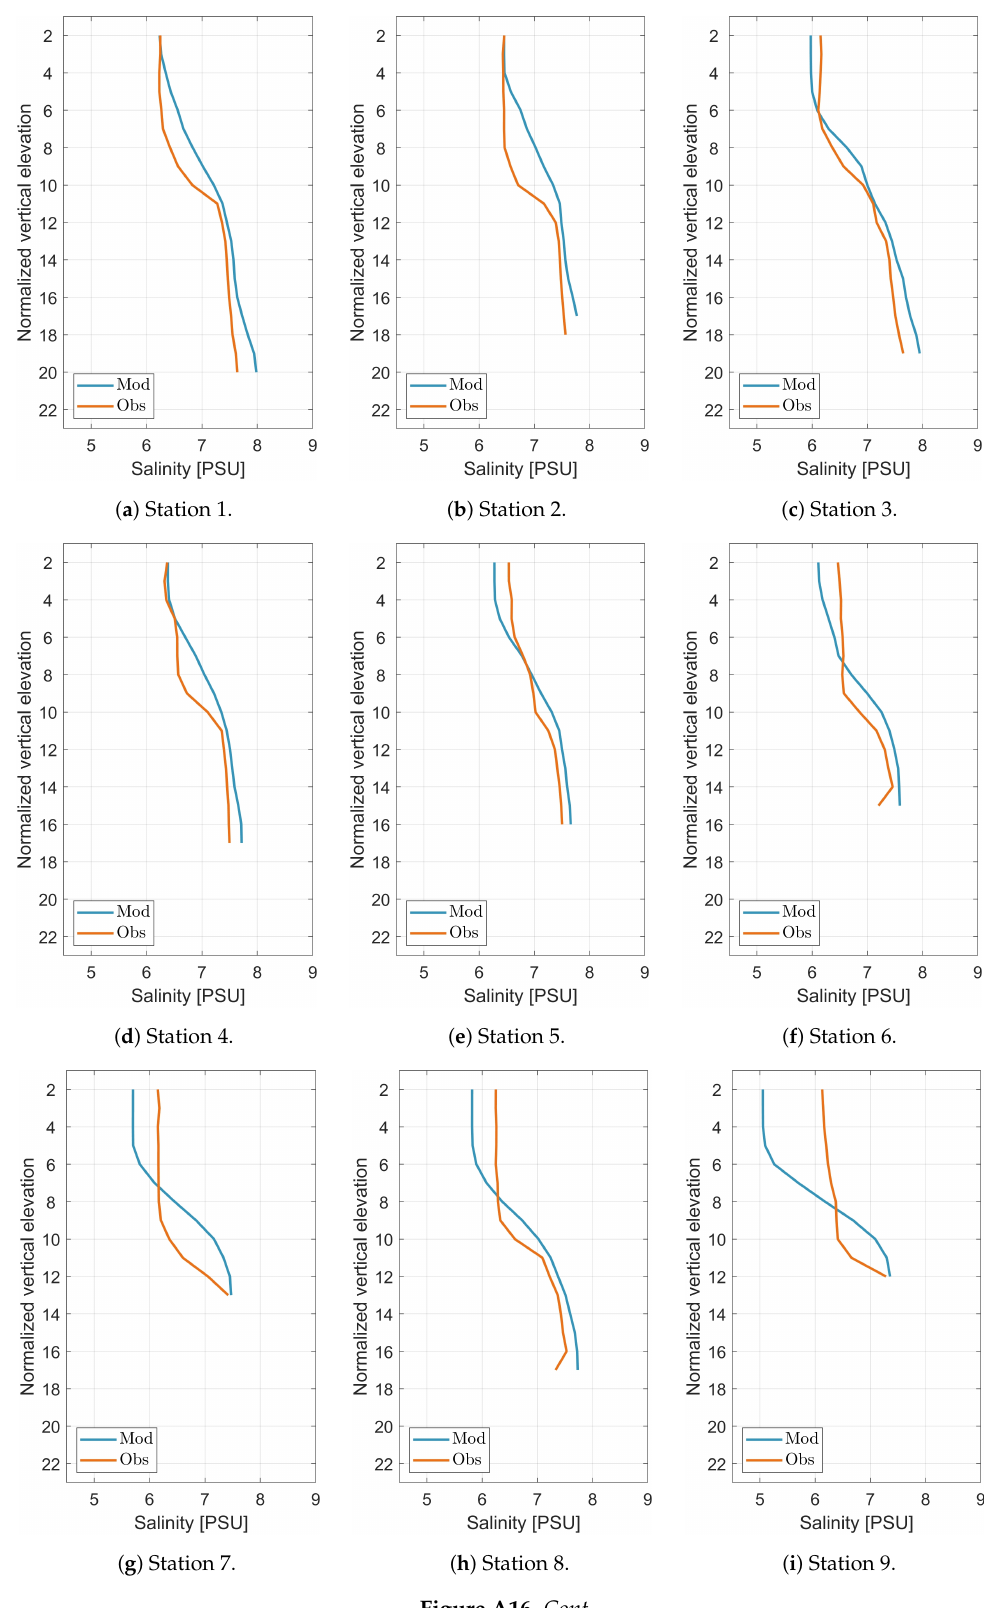
Figure A16. Cont